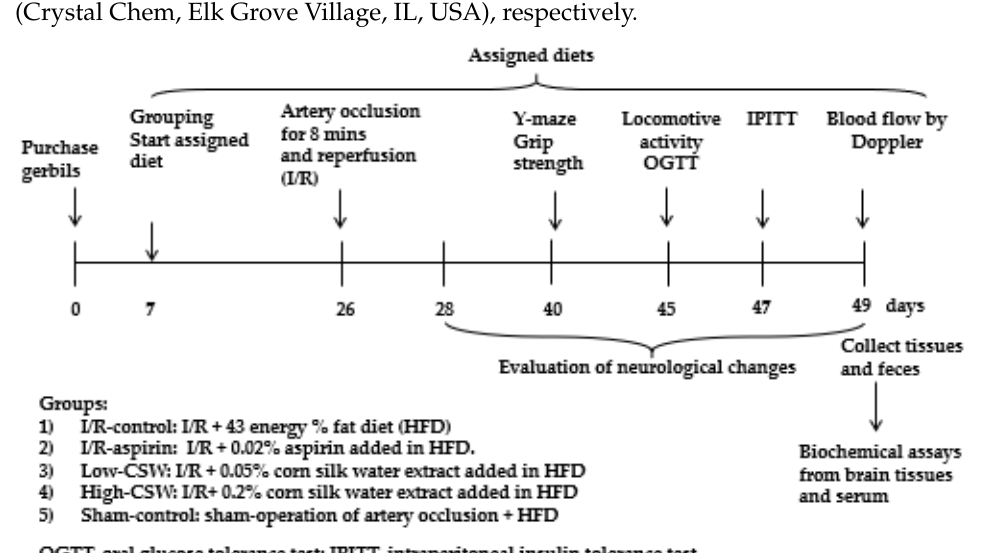
Figure 1. Experimental design.